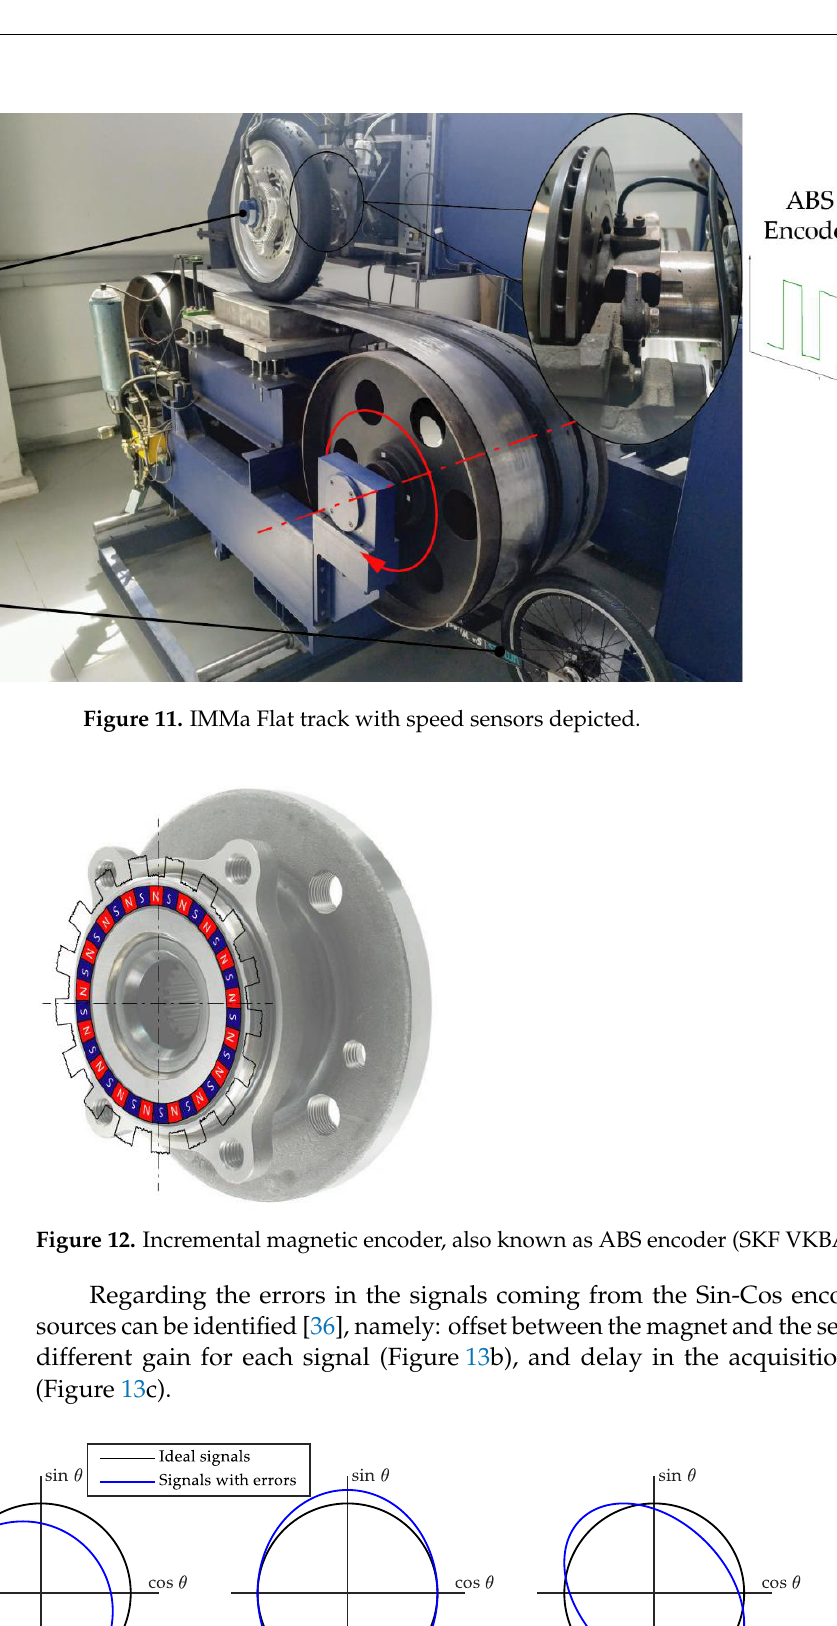
Figure 13. Three possible errors in the output signal of the Sin-Cos encoder. ( a ) Offset. ( b ) Differ- ent gains. ( c ) Adquisition delay. None of the previously mentioned errors were observed when the Kistler RoaDyn P625 and sbRIO-9637 acquisition system were used (Figure 14). In any case, errors of type ( a ) and type ( b ) can be corrected by adding an offset and modifying the gain of one of the signals respectively. Both measurement corrections require a very low computational cost.